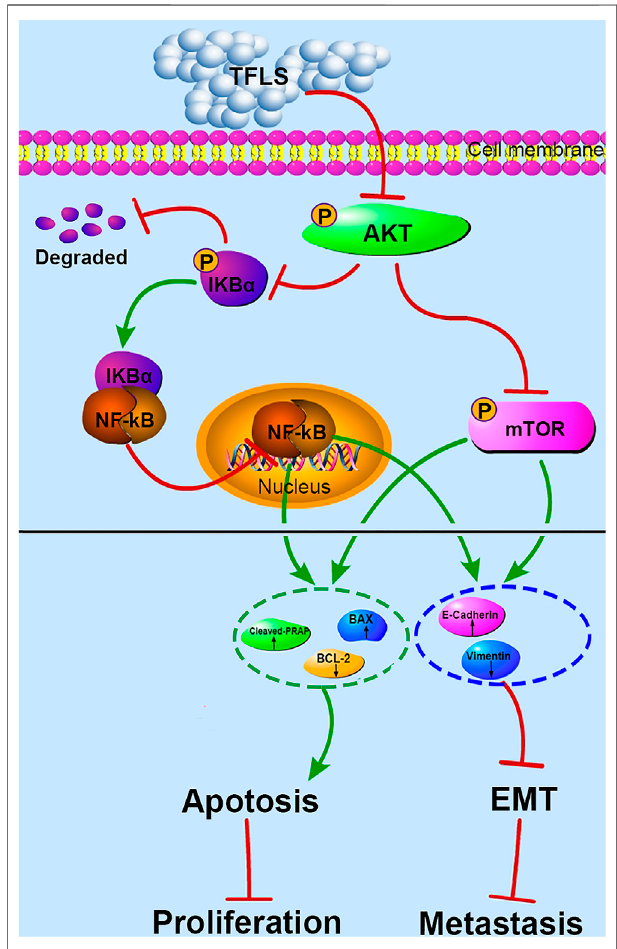
FIGURE 11 | Proposed mechanism of TFLS anti-PCa cells. In brief, TFLS inhibited the phosphorylation of AKT after entering cells, which resulted in decreased phosphorylation of mTOR and I κ B α . Then, I κ B α and NF- κ B combined to form complex of NF- κ B-I κ B α , which suppressed NF- κ B to translocate into the nucleus. The reduction of mTOR phosphorylation and inhibition of NF- κ B ’ s nuclear translocation thus regulated the expression of apoptosis- and EMT-related proteins. As a result, cancer progression was